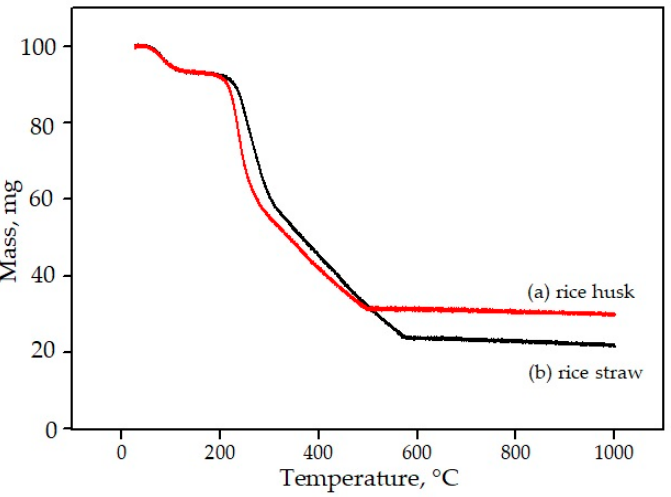
Figure 7. TG curve for ( a ) rice husk and ( b ) rice straw after firing at 1000 °C.